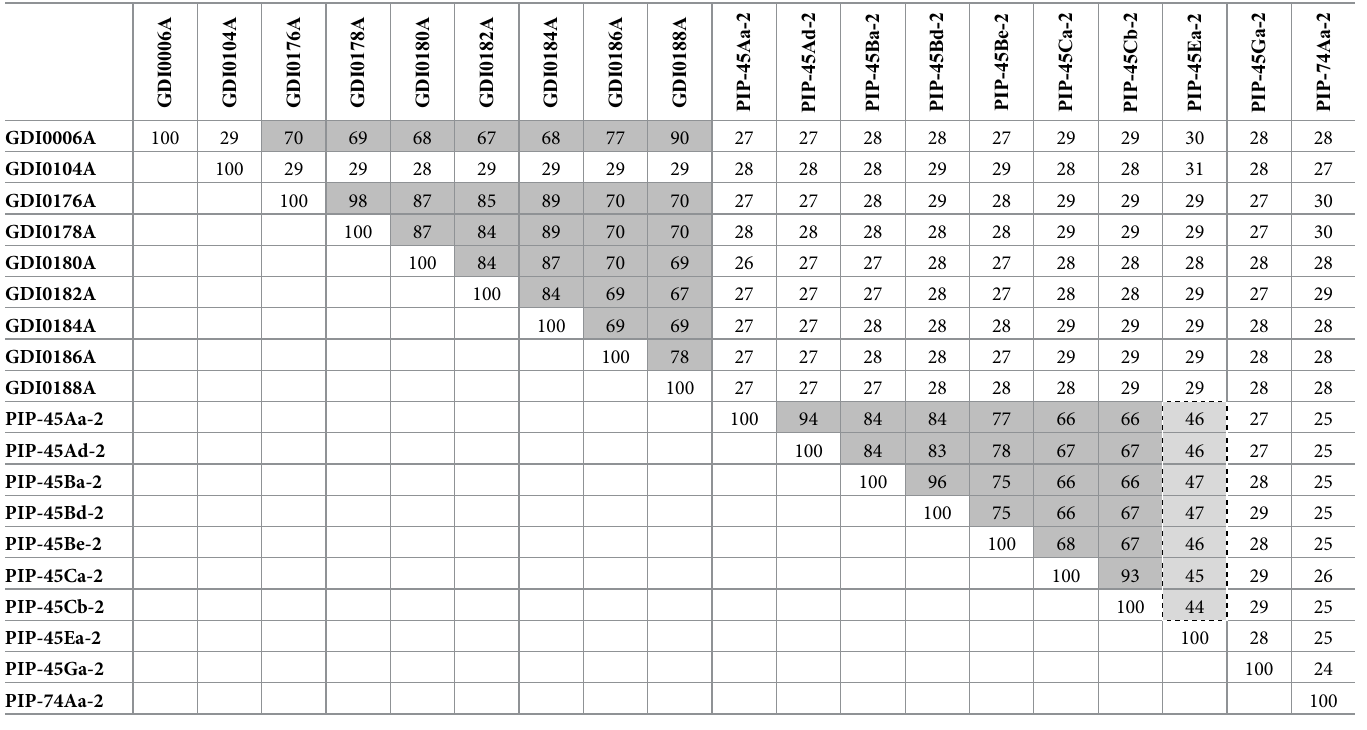
Table 2. Percentage of amino acid identity between members of the PIP45, PIP75 and novel discovered GDI0006A protein